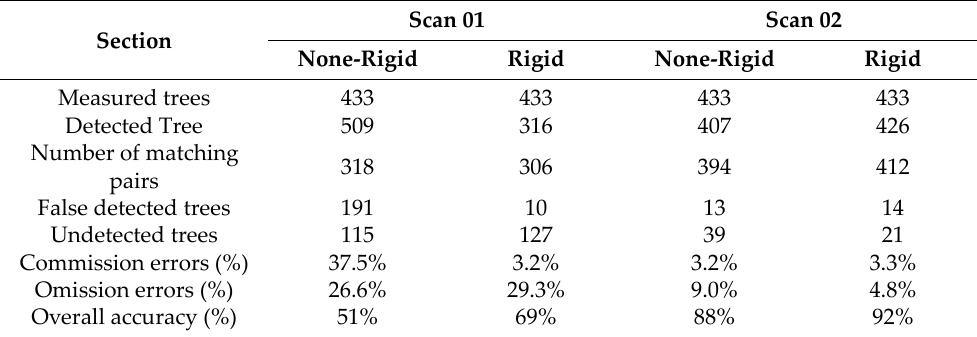
Figure 6. Diagram illustrating the number of matching tree pairs created on the y -axis and distance at which the matching is created on the x -axis. Distance between detected and reference trees was computed in the 2D space using detected locations from tree stems detected in FSCT and the measure locations during the field campaign. The maximum distance allowed for creating matching pairs was 2 m. Results are presented for two scans (Scan 01 and Scan 02) and two-point cloud transformation modes (rigid and none-rigid). Table 4. Summary of tree detection results processed by FSCT for each of the four scans tested (Scan 01 and Scan 02 under the rigid and none-rigid transformation mode, respectively).